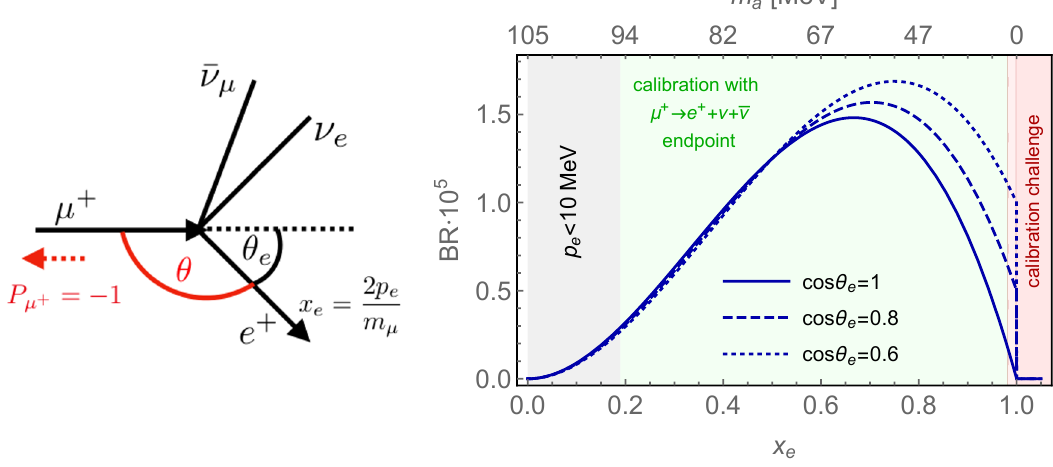
Figure 4 . Left: Cartoon summarizing the relevant kinematical variables in the SM decay of a polarized µ + . Right: Summary of the experimental strategies to hunt for µ + → e + a . The three blue lines show the distribution of the positron spectrum in the SM decay µ + → e + ν ¯ ν for fixed e µ angle cos ¯ θ = 1 , 0 . 8 , 0 . 6 up to a typical angular resolution of δθ = ± 5 × 10 − 3 . The muon beam e e is assumed to be 100% polarized h P = − 1 and as a consequence the positron distribution drops µ i after having a maximum at x (see eq. (3.3)). The value of the branching ratio at the end point max depends on the angular position and resolution (see eq. (3.4)). In the gray region the positron momentum is below 10 MeV and typically not recorded, in the green region µ + → e + a can be searched as a spike on the Michel background. In the red region looking for the signal spike of µ + → e + a requires to overcome challenges in the calibration of the instrument. The two different red lines correspond to two different momentum resolutions as in eq. (3.6): 0.13% in Jodidio et al. [9] and 1.8% in TWIST [10] (see text for